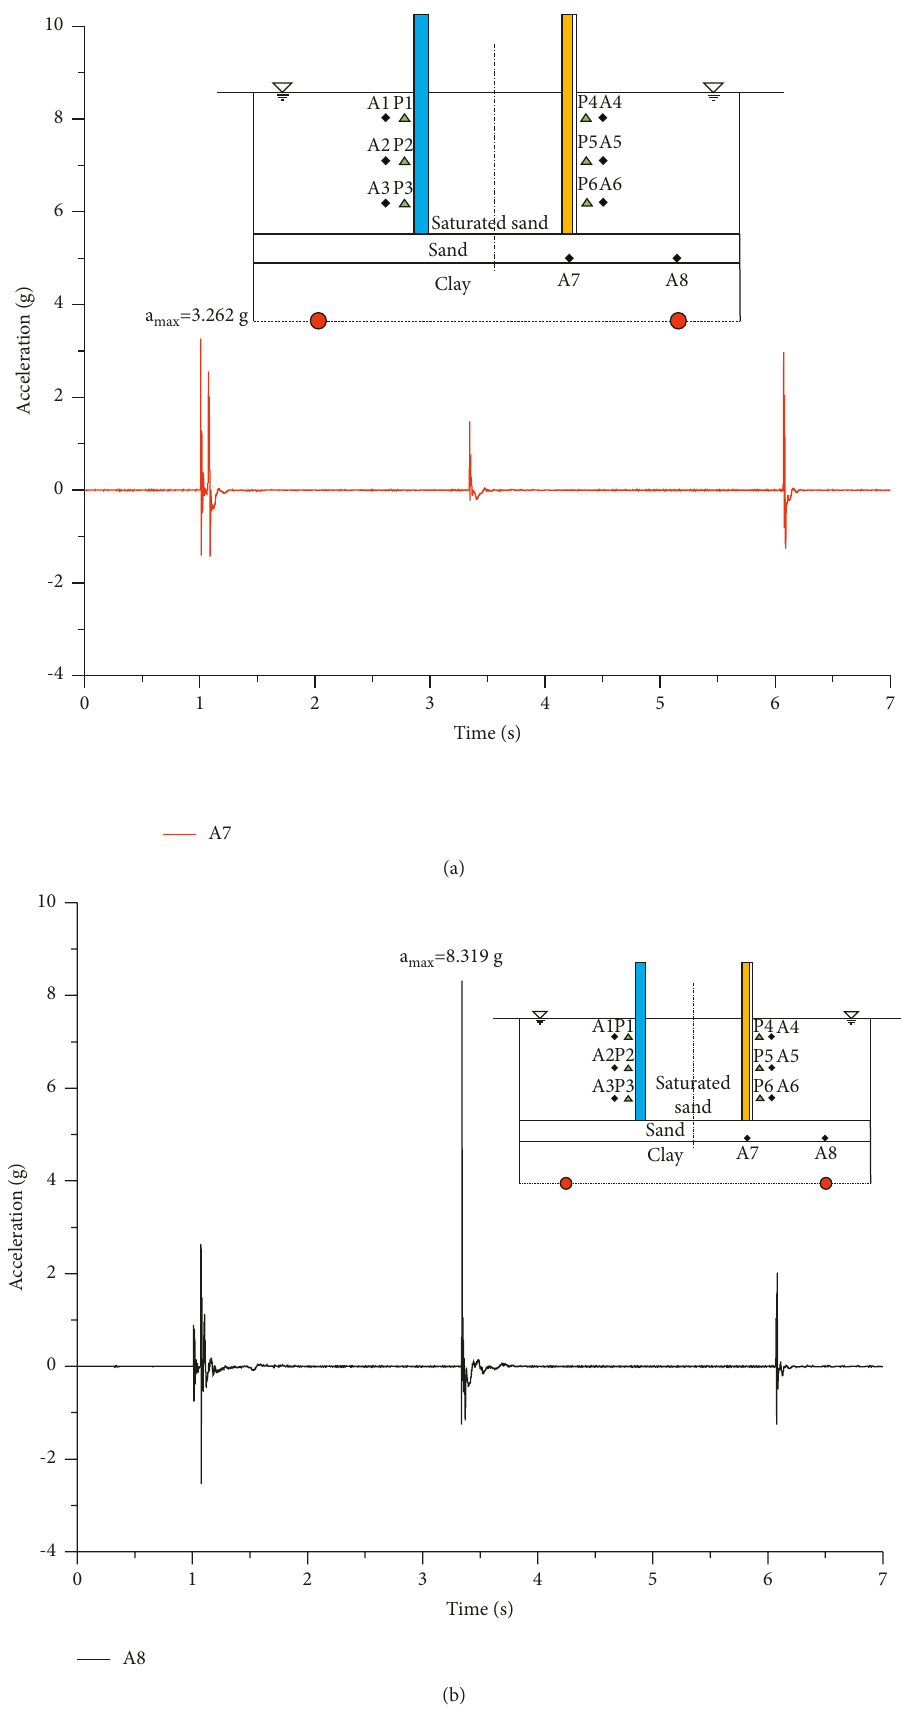
Figure 14: Vertical acceleration response of pit bottom after multiple fracturing blast vibration tests. (a) Vertical acceleration time curve of the A7 sensor. (b) Vertical acceleration time curve of the A8